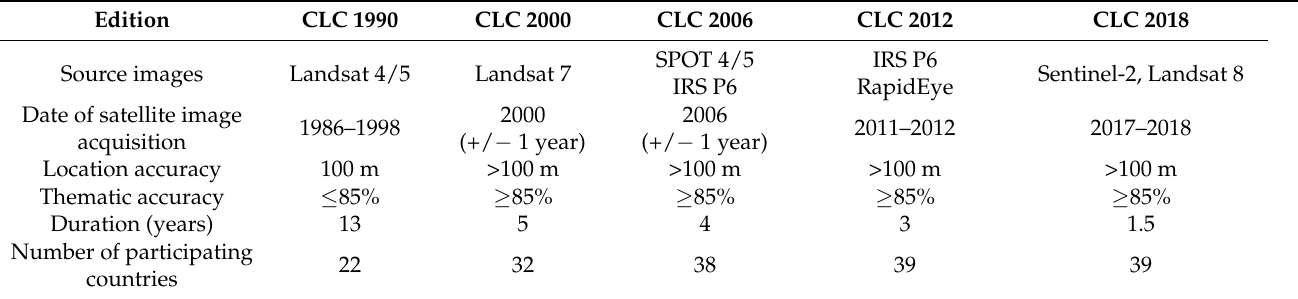
Table 1. Development of the Corine Land Cover project (CLC) [4]; explanation: IRS P6—Indian Remote-Sensing Satellite-P6 of Indian Space Research Organization, Bangalore,